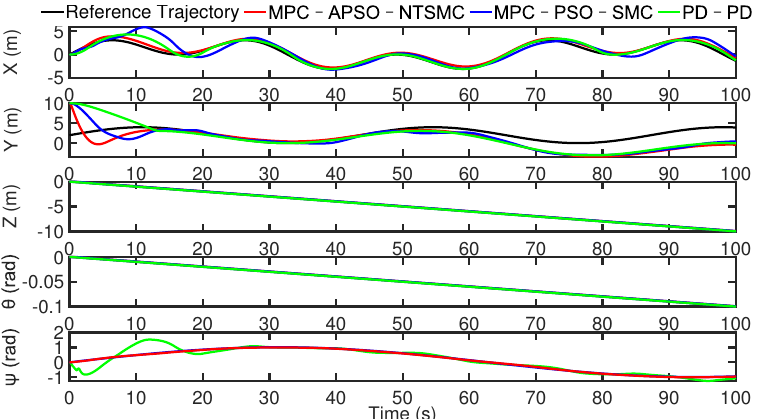
Figure 30. Position tracking performance for the tracking task with wave and current disturbance for Case